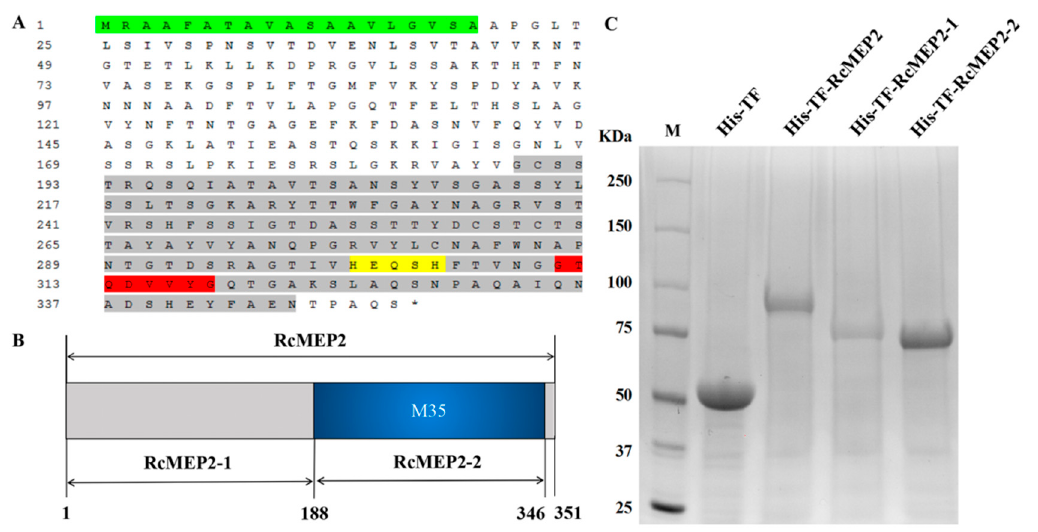
Figure 3. Protein structure of RcMEP2 and heterologous expression of RcMEP2 and its M35-containing / deleting mutants. ( A ) The deduced amino acid sequence of RcMEP2. Green part represents the signal peptide, yellow highlight indicates the HEQSH motif, the red indicates another motif GTQDVVYG, the M35 domain is marked by the grey. ( B ) Schematic view of the RcMEP2 and M35-containing / deleting domain proteins that are heterologously-expressed in Escherichia coli cells. ( C ) Sodium dodecyl sulphate-polyacrylamide gel electrophoresis (SDS-PAGE) patterns of the heterologous-expressing and purified proteins of His-TF-RcMEP2, His-TF-RcMEP2-1 (the M35 domain-deleting peptide), and His-TF-RcMEP2-2 (the M35 domain-containing peptide).